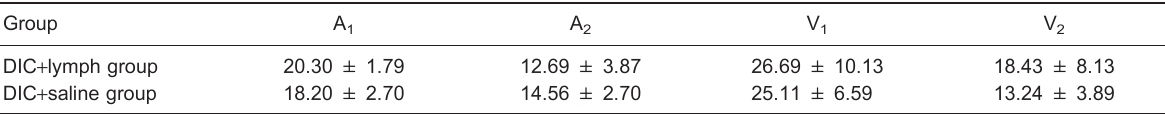
Table 2. Basal values of arteriole and venule diameters.